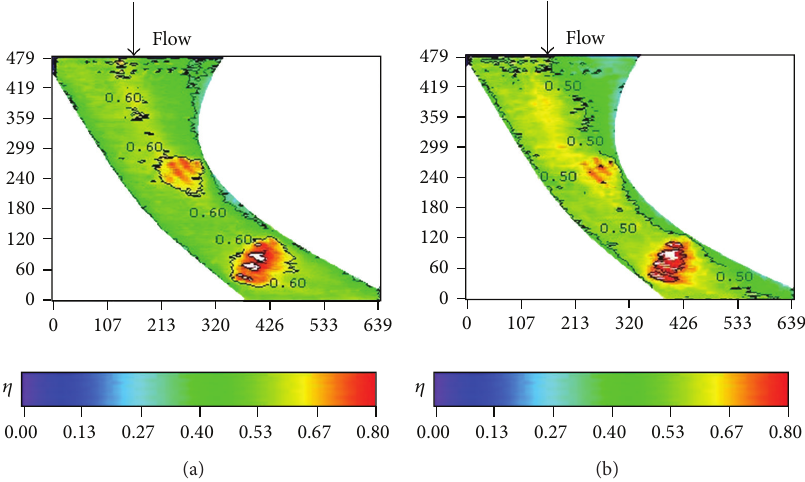
Figure 16: Effectiveness distributions on stepped endwall at low turbulence intensity (Re = 124000 , 𝑀 = 1 , and T . I . = 1.8 %). (a) 𝑆/𝐶 = 4 %. (b) 𝑆/𝐶 = −4 %.